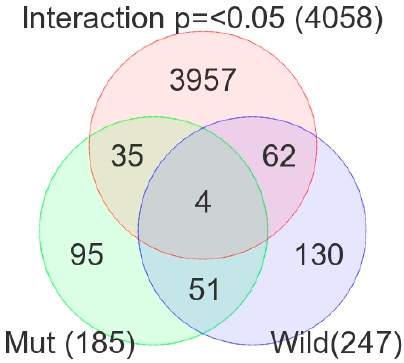
Figure 3. Overlap between the lists of DML (FDR 0.05) in BRAF mutant patients (light green), BRAF wild-type patients (light blue), and the methylation markers with significant ( p ≤ 0.05) interaction for “tissue x mutation” in ANOVA (in pink).